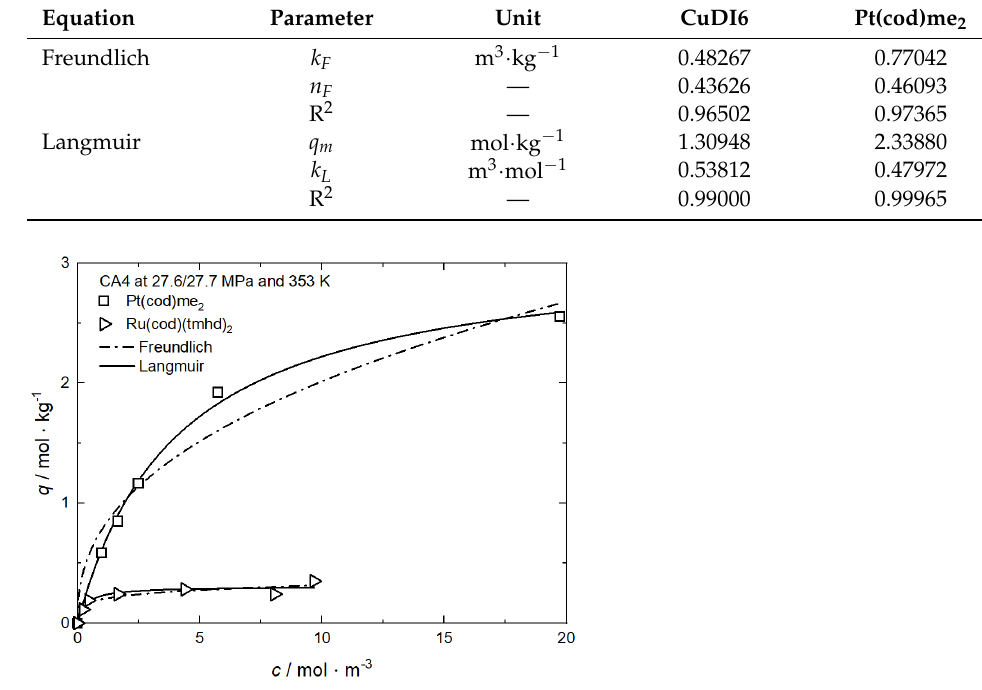
Figure A18. Uptake of different precursors on CA4 at 27.6/27.7 MPa and 353 K; experimental data taken from [37,53]. Table A18. Adsorption isotherm parameters of different precursors from scCO 2 solution on CA4 at 27.6/27.7 MPa and 353 K [37,53].